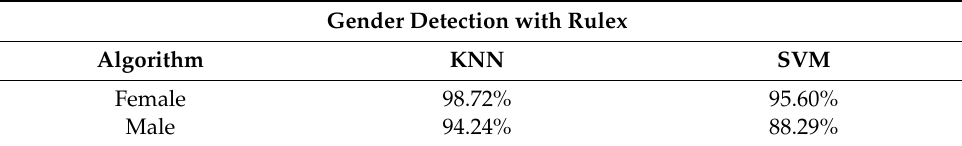
Table 5. Forecast accuracy for Gender Image